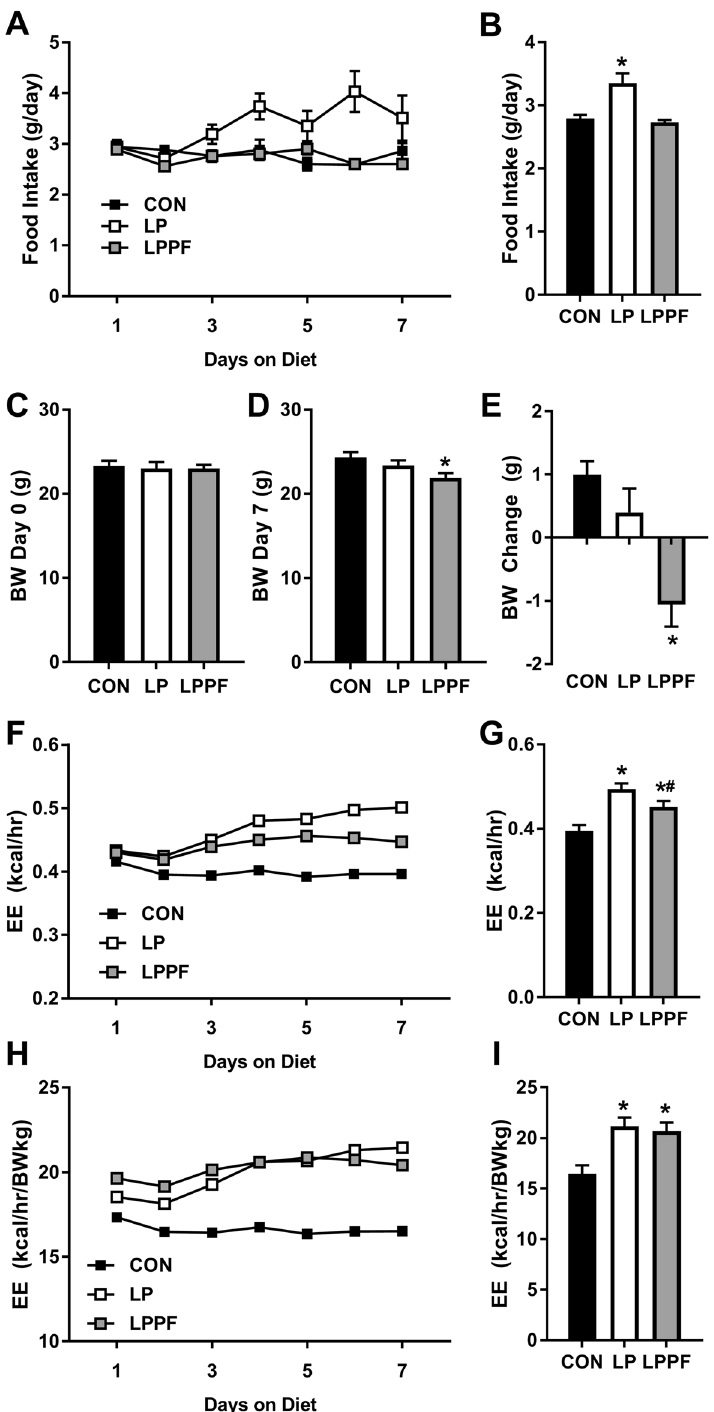
Figure 6. Hyperphagia is not necessary for low protein-induced increases in energy expenditure. Wildtype mice were placed on control or LP diet ad libitum for 7 days, or were placed on LP but pair-fed to the daily intake of the control group (LPPF) to prevent hyperphagia. Daily food intake ( A , B ), body weight on day 0 ( C ) and day 7 ( D ), and BW change for the 7 days ( E ). Unadjusted average daily energy expenditure ( F ) and averaged across days 5–7 ( G ) and EE adjusted for body weight on day 7 ( H and I ). 8 mice/group. * P < 0.05 vs. control. # P < 0.05 vs.